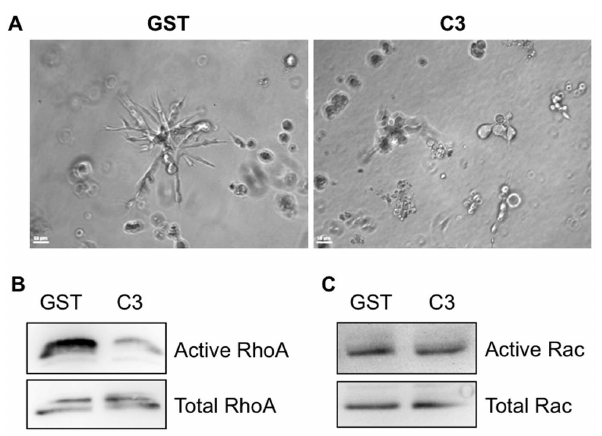
Figure 4. Rho GTPases are required for the invasive growth of MDA-MB-231 cells. Cells were electroporated with 5 m g GST or GST- C3 exotransferase, then seeded in 3D Matrigel and imaged (A) as described in Figure 3, or assessed for RhoA (B) and Rac1 (C) activities as described in the Methods section.